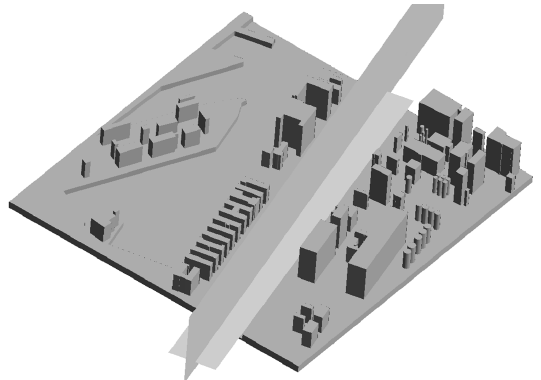
Figure 14. Auxiliary planes visualizing the wind field distribution.